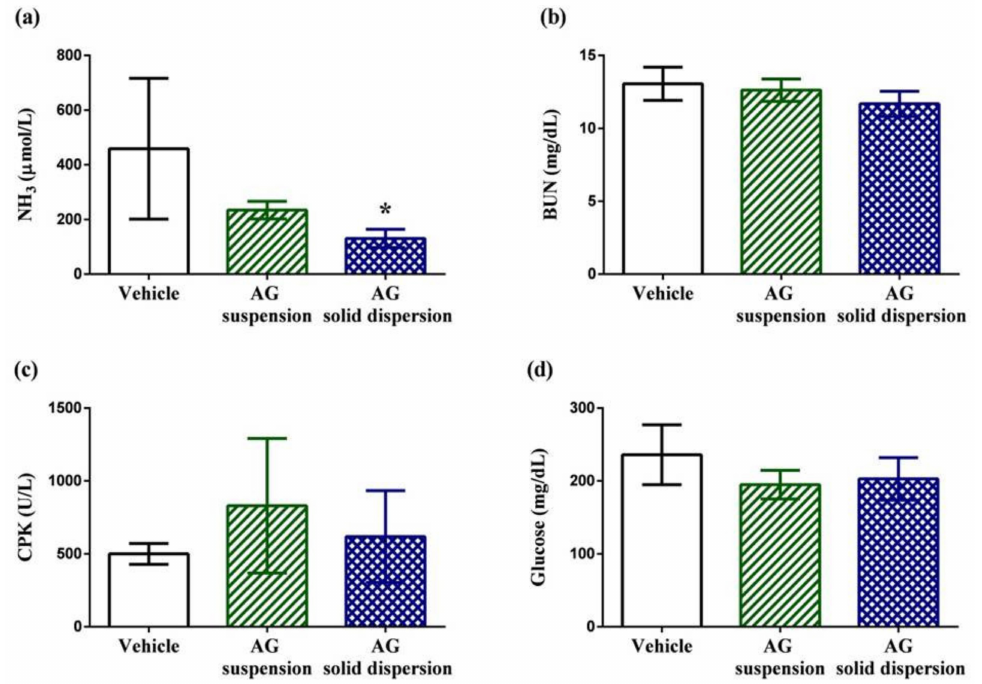
Figure 9. E ff ect of andrographolide (AG) on: serum ( a ) ammonia; ( b ) blood urea nitrogen (BUN); ( c ) creatine phosphokinase (CPK); and ( d ) glucose levels after swimming challenge. Data are expressed as mean ± standard deviation ( n = 5 for each group). * Indicates significant di ff erence compared to vehicle group ( p <